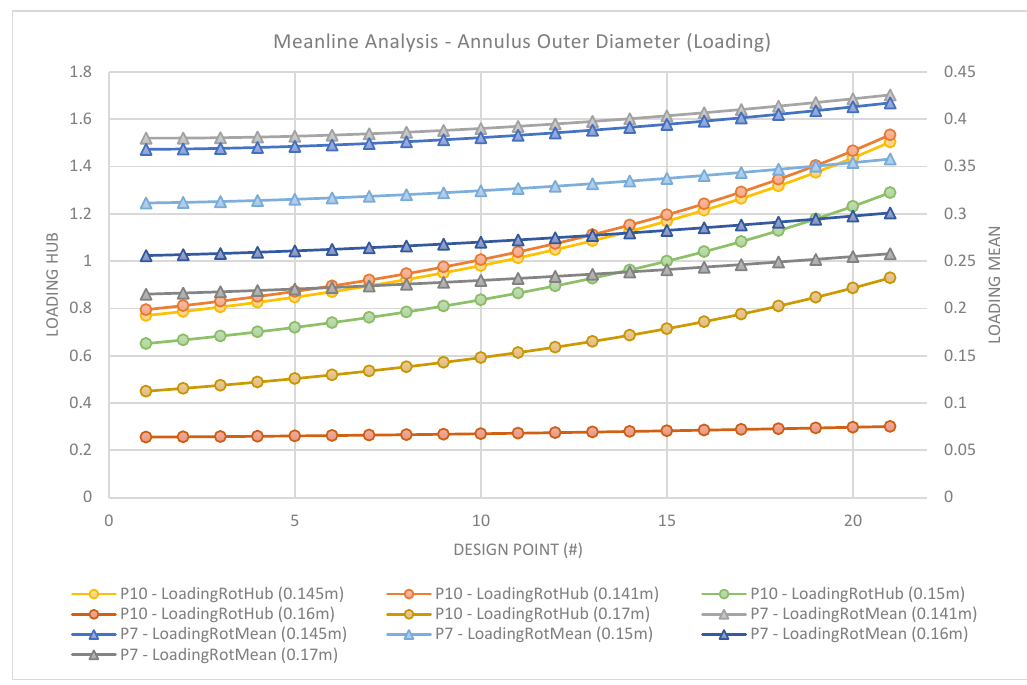
Figure 12. Meanline analysis for the outer diameter (DeHaller number).